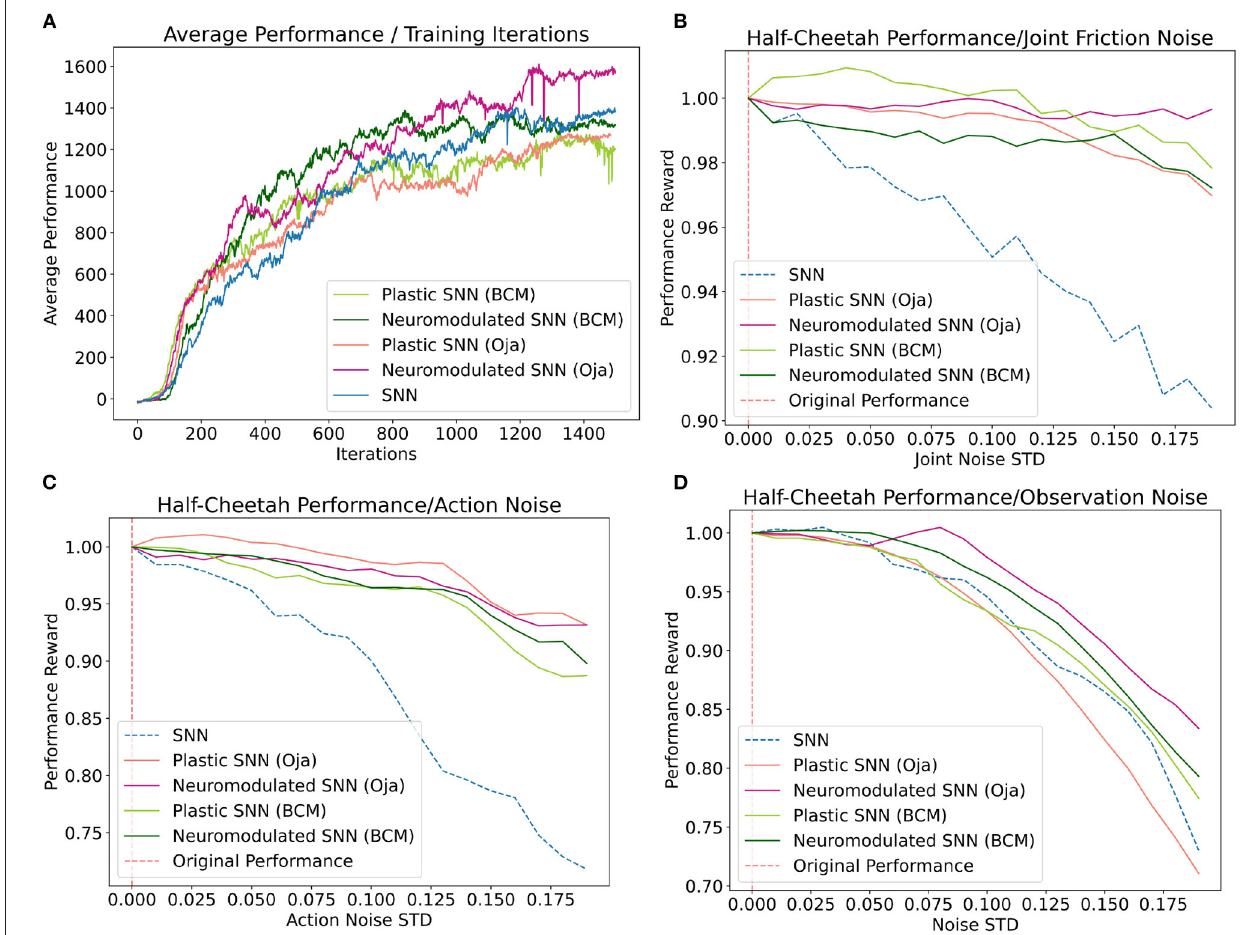
FIGURE 4 | (A) Average performance of each network at each iteration of the training process. (B–D) Average loss in performance as a ratio of the observed performance in response to noise [x-axis] and the original network performance in the absence of noise at x=0. Averages for each noise standard deviation were collected over 100 training